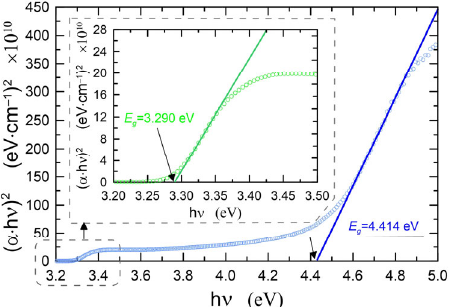
Figure 5. Plots of ( α h ν ) 2 versus photon energy for the structure ZnO ‐ 64.